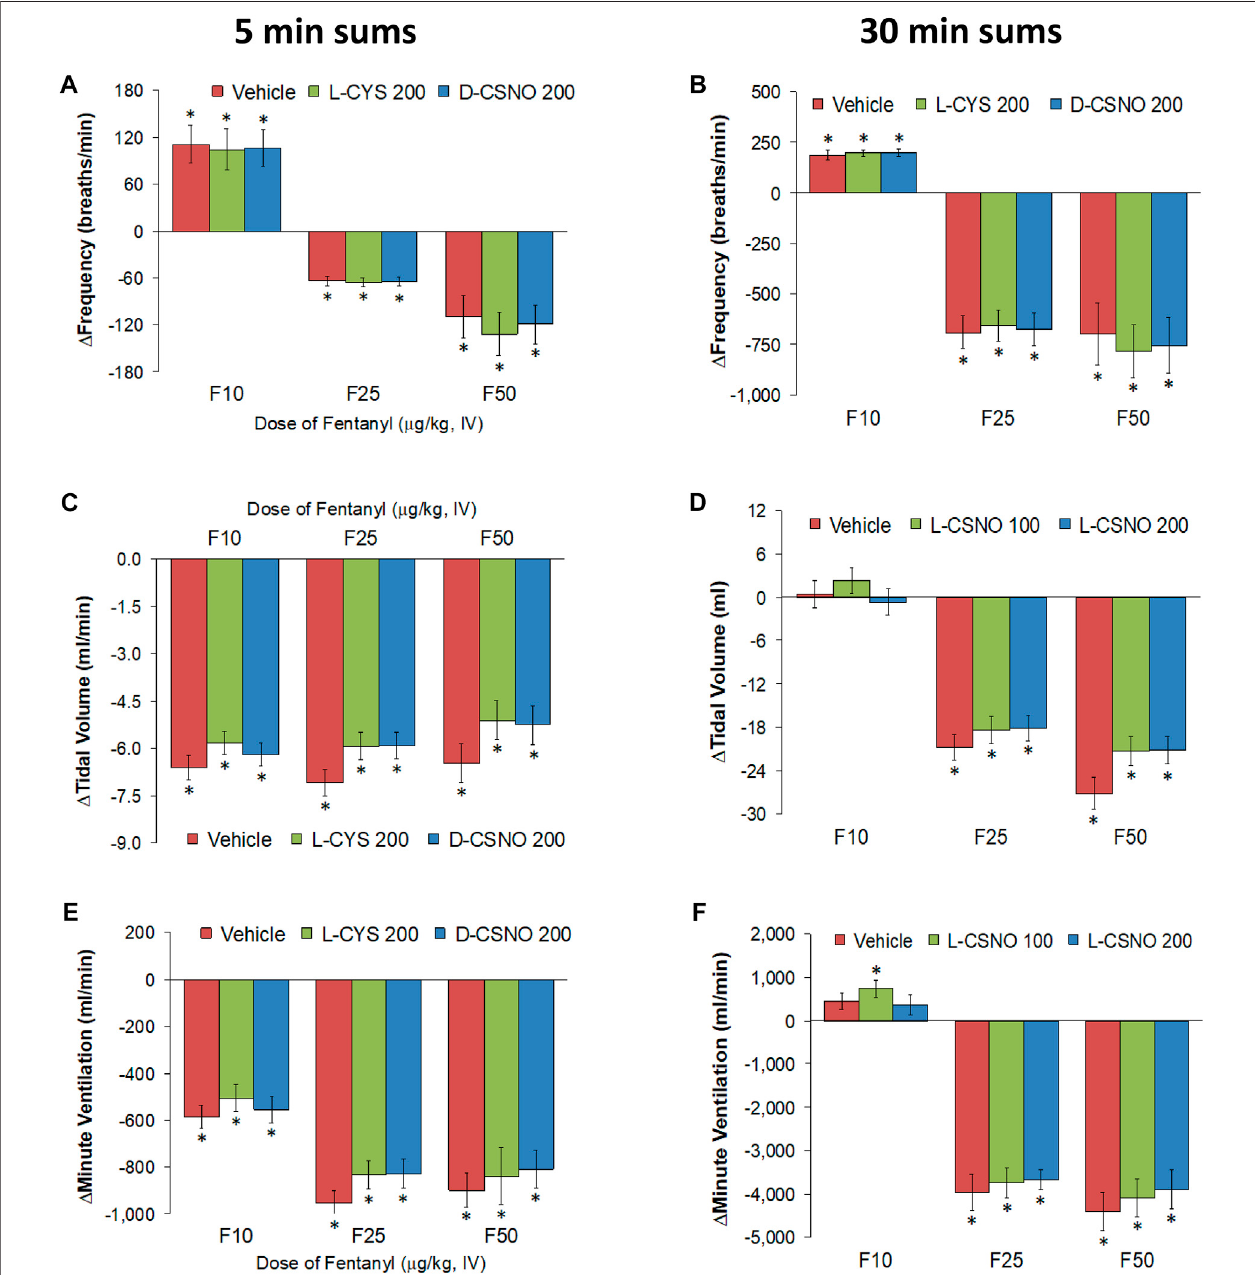
FIGURE 8 | Total (cumulative) arithmetic changes in Pre values during the fi rst 5 min and entire 30 min periods in frequency of breathing (A,B) , tidal volume (C,D) , and minute ventilation (E,F) after injection of fentanyl at F10 (10 μ g/kg, IV), F25 (25 μ g/kg, IV), and F50 (50 μ g/kg, IV) in rats receiving infusion of vehicle (20 μ l/min, IV), L-cysteine (200 nmol/kg/min) or D-CSNO (200 nmol/kg/min). The data are presented as mean ± SEM. There were 8 rats in each group. * p < 0.05, signi fi cant change from Pre values.